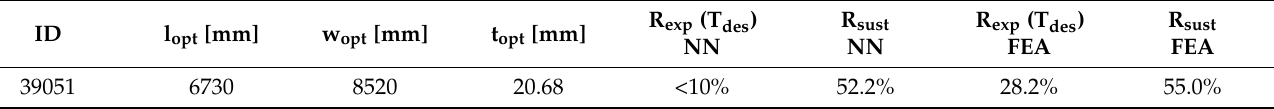
Table 8. Loops optimal geometry and performances (NN predicted and FEA